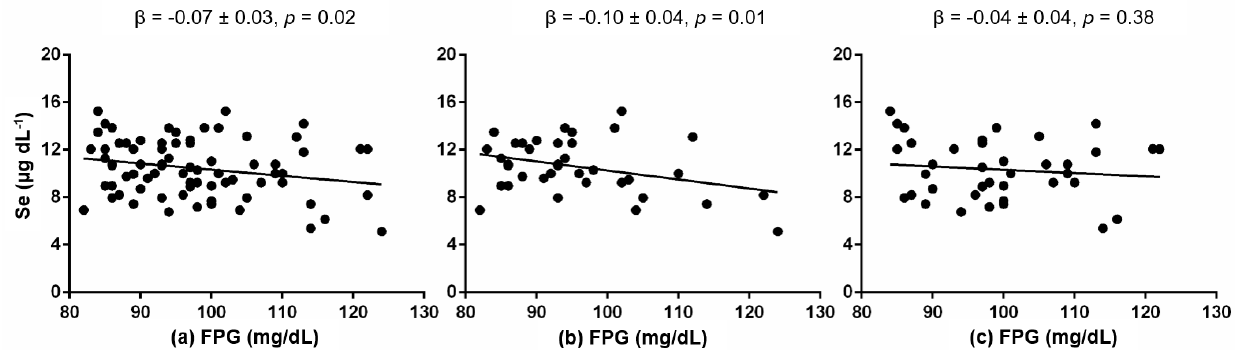
Figure 2. Association between fasting plasma glucose (FPG) and serum Se levels in the whole sample ( a ) and separately in women ( b ) and men ( c ). Analysis by linear regression model adjusted for age, sex and body mass index (whole sample), and for age and body mass index (separately in women and men).